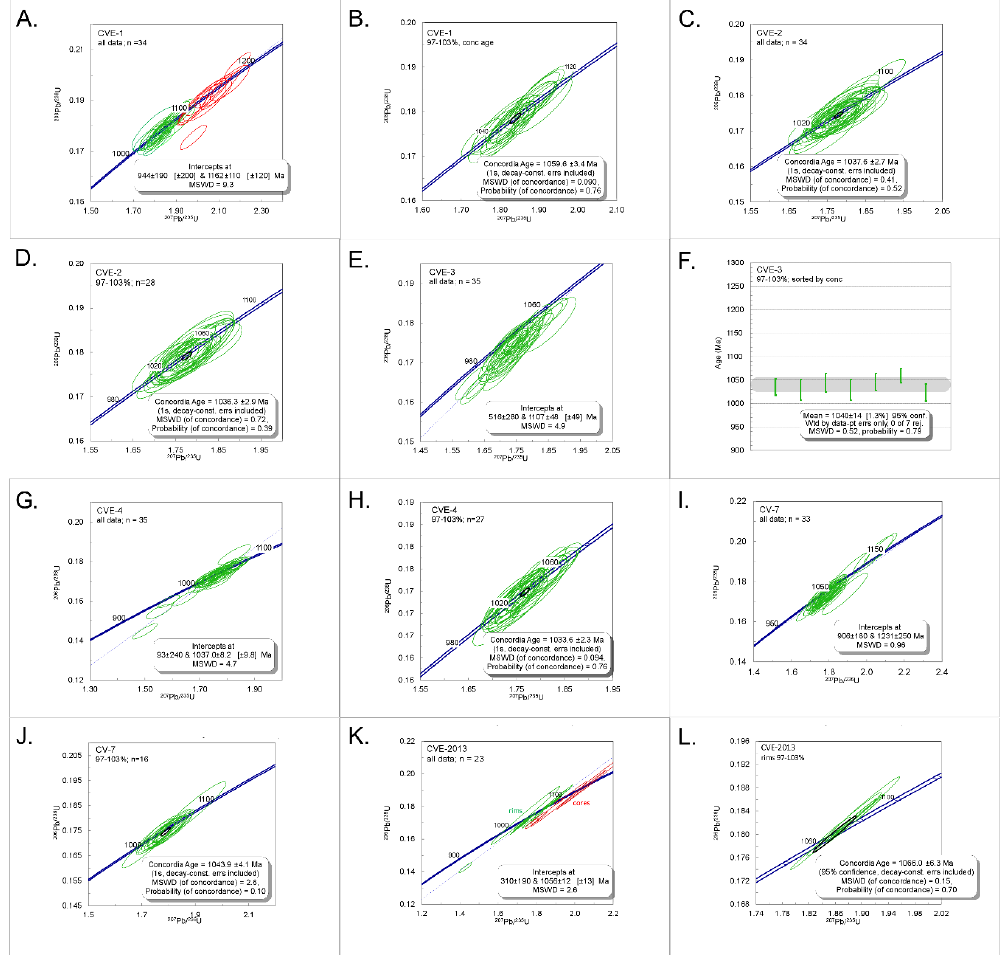
Figure 7. Weighted average and concordia diagrams for the samples analyzed in this study. ( A & B ) CVE-1, ( C & D ) CVE-2, ( E & F ) CVE-3, ( G & H ) CVE-4, ( I & J ) CV-7, and ( K & L ) CV-2013. Table 2. U-Pb zircon geochronological results from ore and altered host rock, Cheever Mine, NY. Sample Lat./Long. in